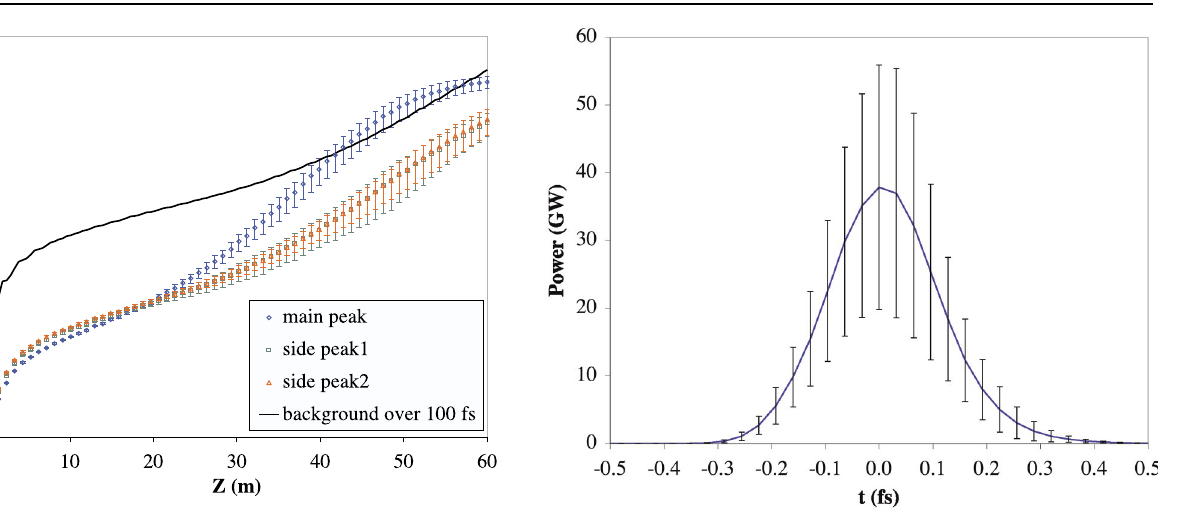
FIG. 10. (Color) Time dependence of the average radiation power, with statistical deviations arising from different random seeds for the shot noise.